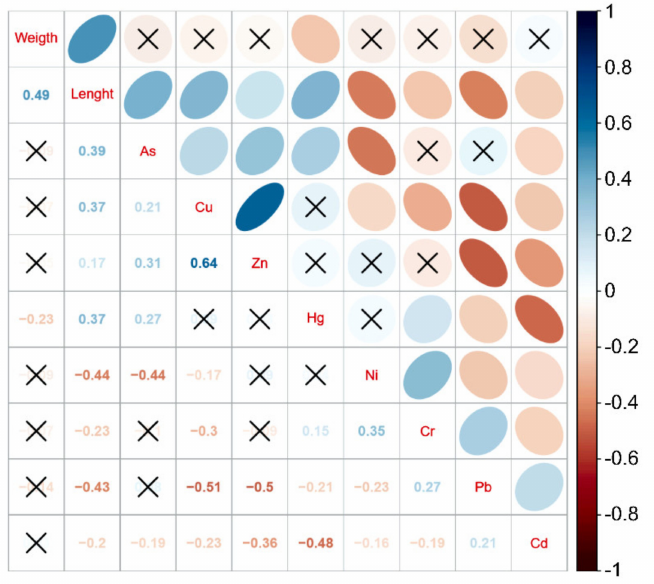
Figure 3. Correlation analysis between fish body length and trace metal. Note: a. The clockwise points indicated a positive correlation and counterclockwise points indicated a negative correlation; b. × implies p >